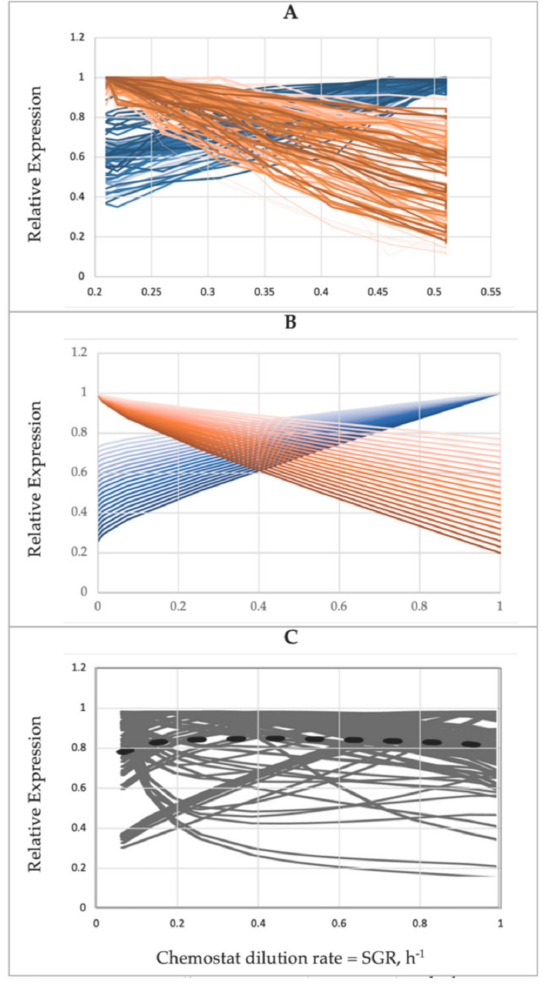
Figure 5. The conditional expression of proteins as dependent on the dilution rate in a glucose-limited chemostat culture of E coli. ( A ) Proteomic data [21]. Out of 1525 detected proteins, we selected the most abundant 350 proteins representing 91% of the proteome mass and normalized each protein to its maximum. Blue and orange curves stand, respectively, for the up- and downregulated proteins. ( B ) SCM computing of 40 ad hoc up- and downregulated proteins. ( C ) Profile simulated by the ME model